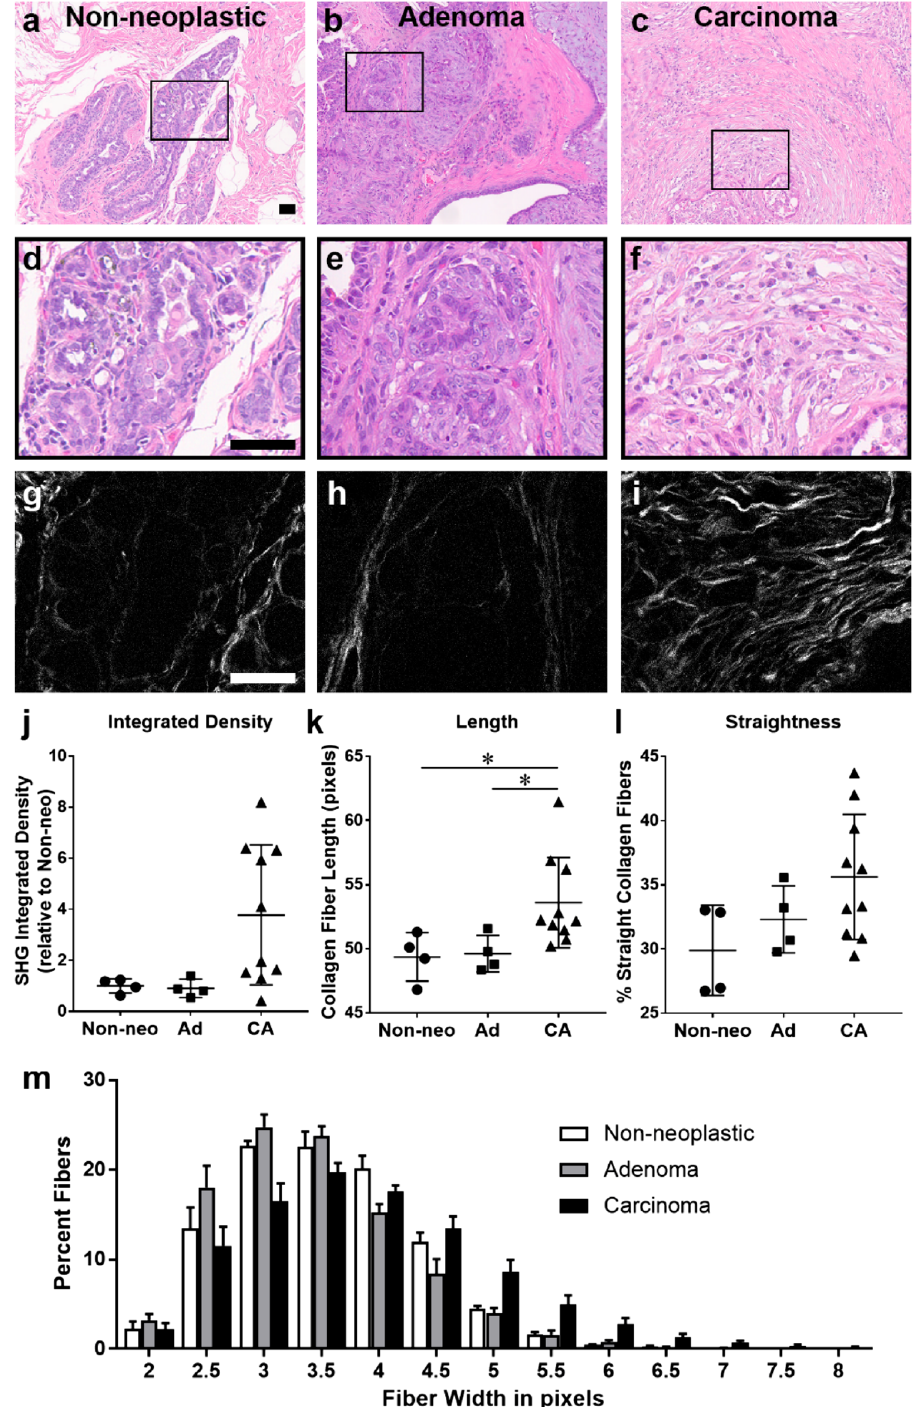
Figure 1. Collagen fiber characteristics in canine mammary tissue. ( a – f ) H&E and ( g – i ) second harmonic generation (SHG; collagen in white) images from non-neoplastic ( a , d , g ), adenoma ( b , e , h ) and carcinoma ( c , f , i ) samples. Scale bar = 50 µm. Black boxes in a – c correspond to higher magnification images in d – f . ( j – l ) Fibrillar collagen signal (integrated density; j ) as well as fiber length ( k ), straightness ( l ) and width ( m ) was analyzed using the CT-FIRE program (Non-neo: Non-neoplastic n = 4; Ad: Adenoma n = 4; CA: Carcinoma n = 10). Data are presented as means ± SD. The three tissue types were compared using Kruskal–Wallis followed by Dunn’s multiple comparison tests (*, p < 0.05). ( m ) To compare fiber width distributions, histograms were generated (presented as means ± SEM). Non-linear regression was used to find the best fit model for each tissue type and curve values (amplitude, spread, mean) were compared using 1-way ANOVA followed by a Tukey post-hoc test (non-neoplastic vs carcinoma: curve amplitude p = 0.004, curve spread p = 0.011, curve mean p = 0.007; adenoma vs carcinoma: curve amplitude p < 0.001, curve spread p = 0.001, curve mean p <